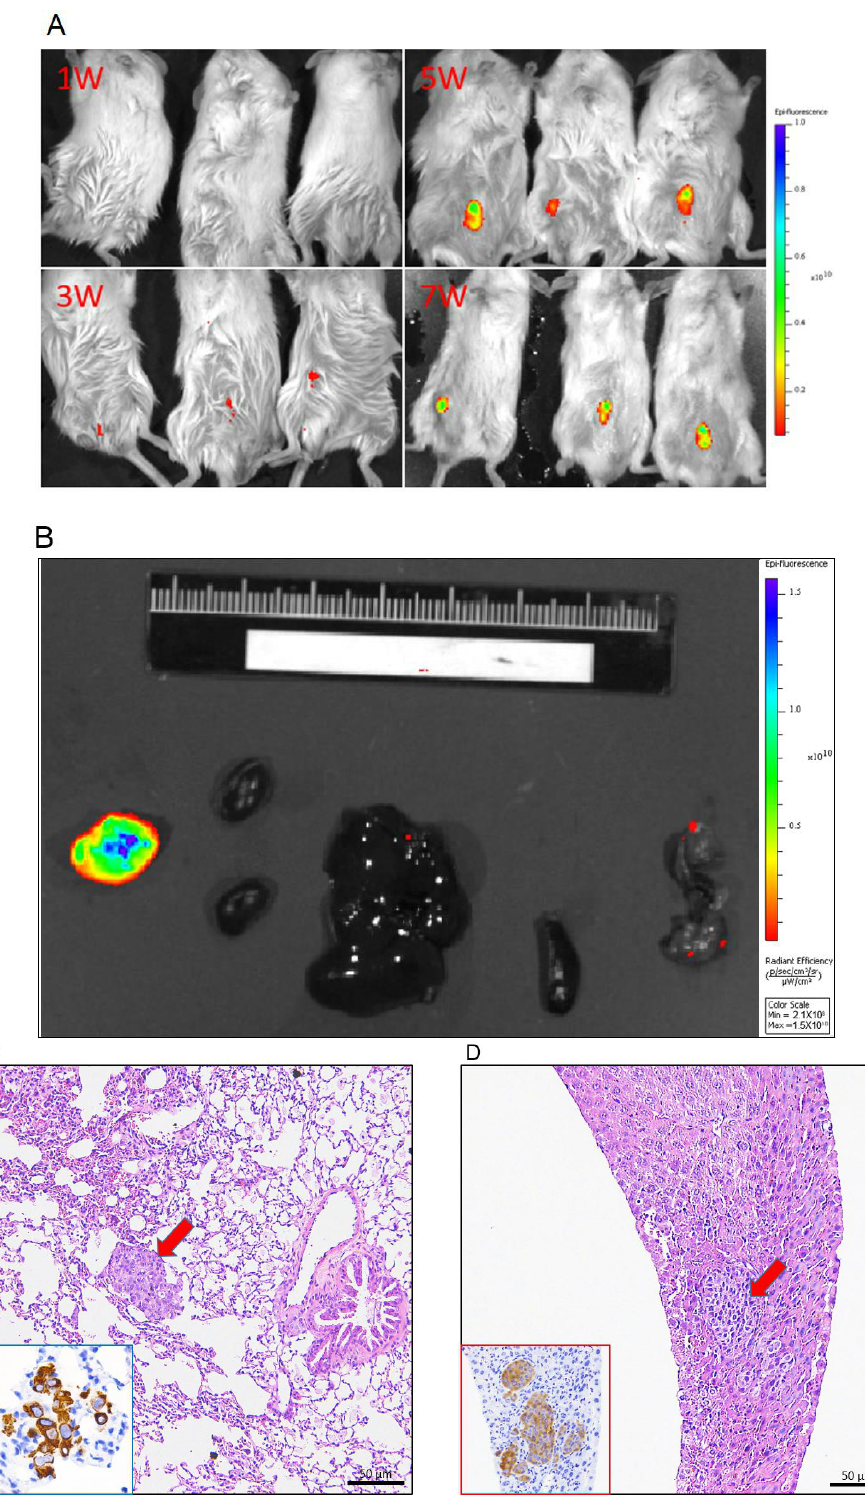
Figure 8. Analysis of NSG mice engrafted withFMT-1807-RFP cells. ( A ) Optical imaging of mice bearing tumors induced by FMT-1807-RFP cells into the inguinal mammary fat pads monitored via ex vivo IVIS imaging. The time course is indicated. ( B ) Tumor spontaneous metastasis to organs monitored via IVIS imaging (from left to right: kidney, liver, spleen and lung). Histopathology of metastatic tumors in mouse models with FMT-1807-RFP cells. H&E staining and IHC staining for vimentin of paraffin sections of lung ( C ) and liver metastases ( D ). The arrows indicate the metastatic